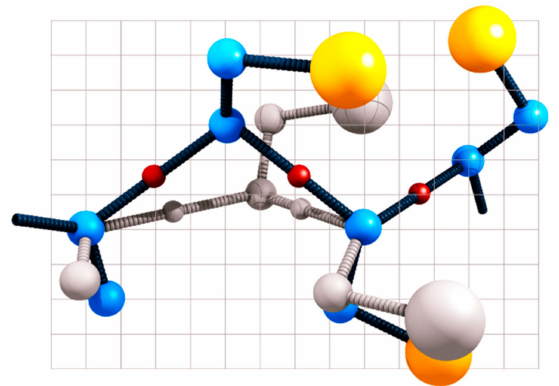
Figure 4. CABS representation of a small protein chain fragment. Positions of C α pseudoatoms are restricted to grid nodes of the underlying simple cubic lattice with spacing of 0.61 Å (for more details see Reference [8,24]). Allowing small fluctuation of the expected C α –C α distance enables hundreds of possible orientations of these pseudobonds. Side-chain pseudoatoms (C β in blue and an additional center of the side chain, where applicable, in yellow) are not restricted to the lattice and their positions are defined by the geometry of the main chain and statistical properties of specific amino acids. A move of a single C α leads to specific displacements of three side chains (new positions of the side chains are shown in gray). Thanks to the high-coordination lattice representation of the main chain geometry, all possible local moves are stored in large precalculated data